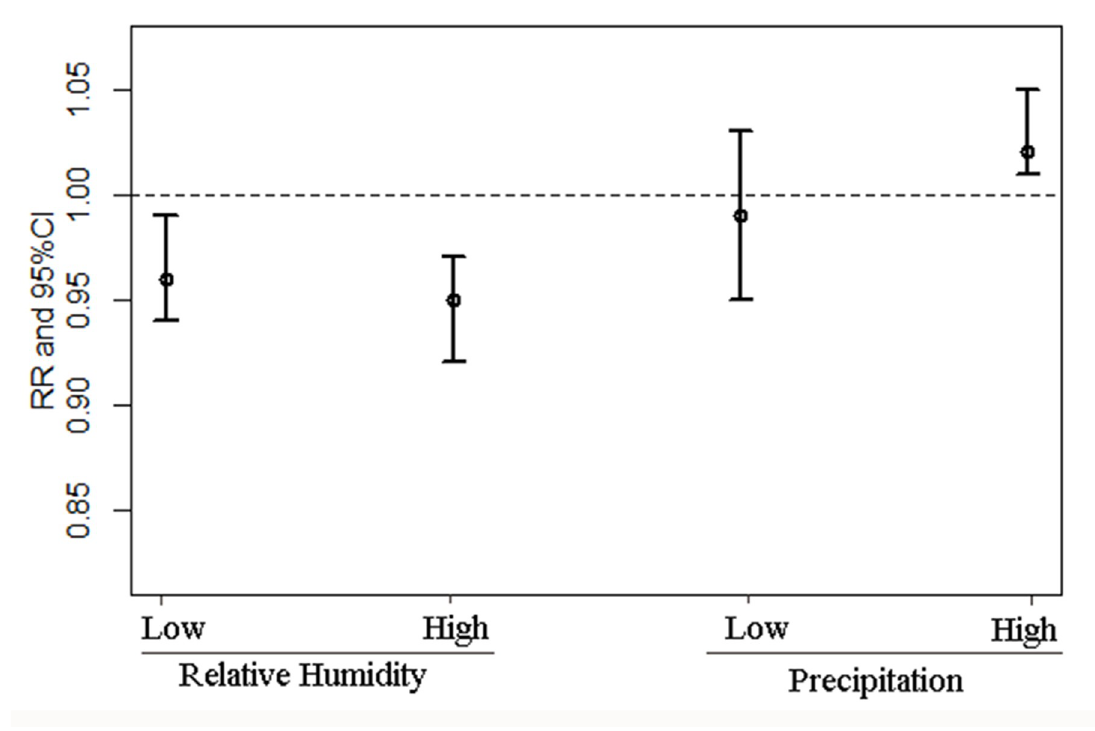
Fig 7. The associations between temperature and HFRS with different strata of relative humidity and precipitation (Abbreviations: RR, relative risk; CI: confidence interval).